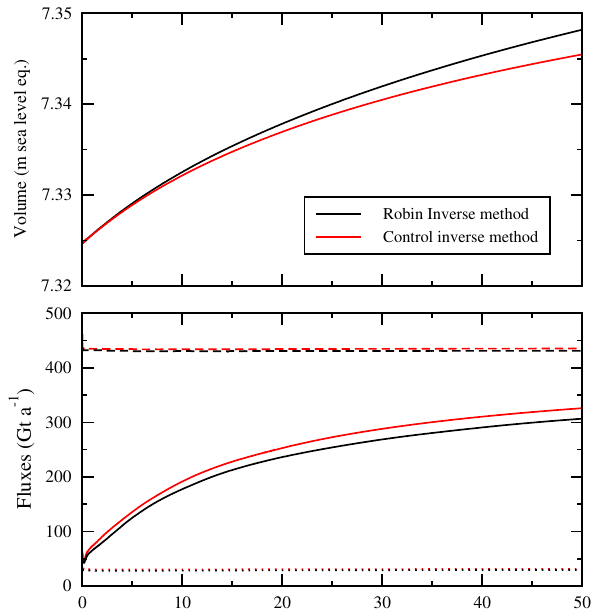
Fig. 7. GrIS mass balance during relaxation: (top) evolution of the total ice volume in meters of sea level equivalent and (bottom) evo- lution of the discharge (solid lines), SMB (dashed lines) and flux through the bedrock (dotted lines) in Gta − 1 .